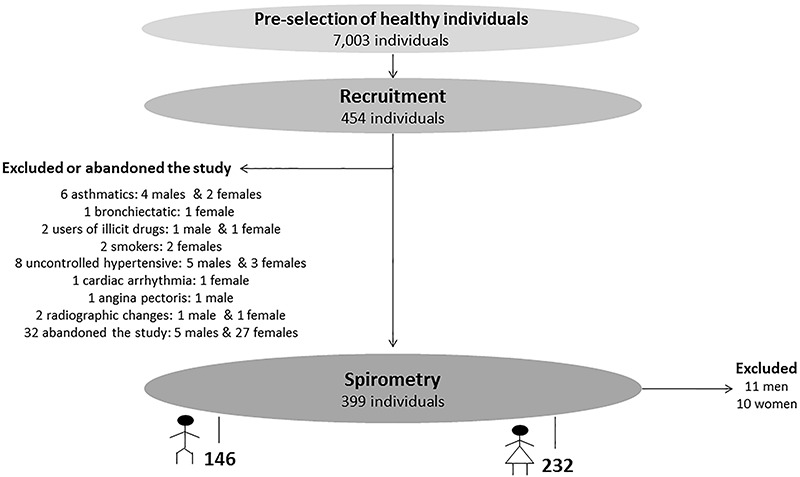
Patient recruitment flowchart. A total of 16.73% excluded or abandoned the study (12.11% during the test stage, 4.62% during spirometry); a total of 83.27% completed all phases.